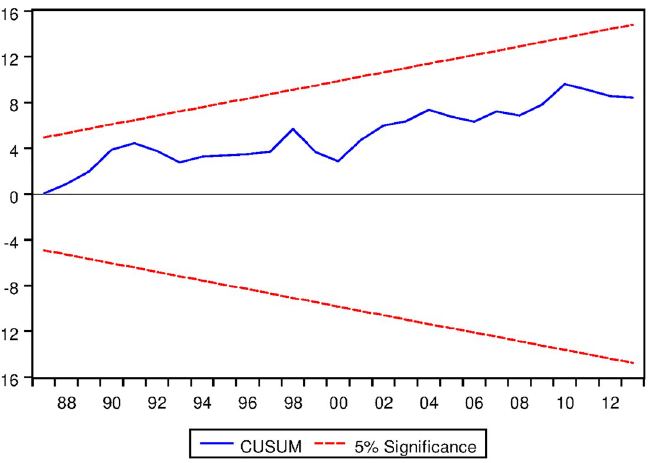
Fig 20. Stability diagnostic of cointegrating relationship for Korean data with constant fixed regressor under proposed framework.